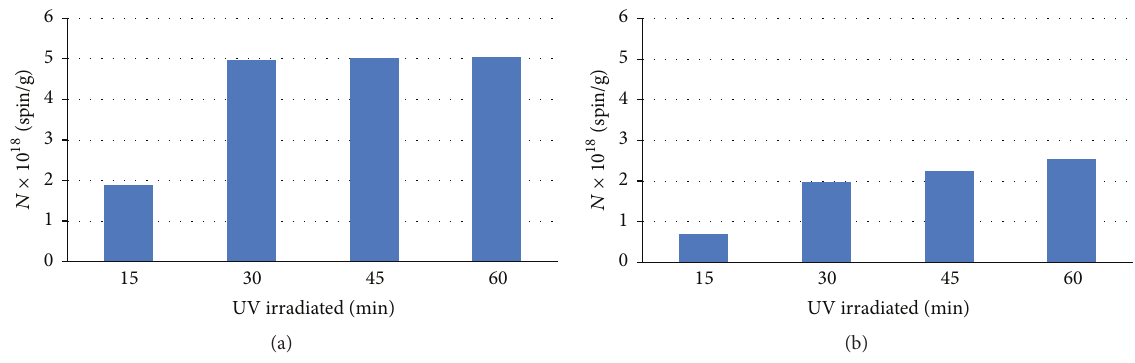
Figure 9: Comparison of free radical concentrations ( 𝑁 ) in (a) salicylic acid and (b) urea, after UV irradiation in different times.